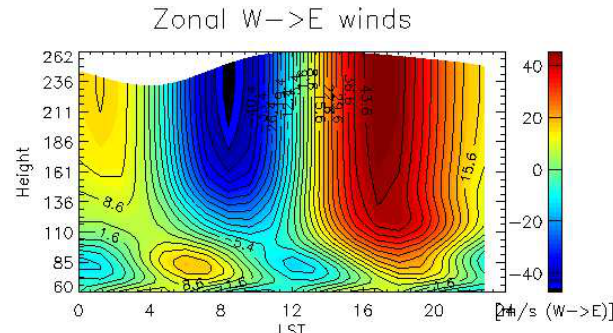
Fig. 7. The zonal wind speeds(positive eastward), local solar time (LST) vs height, from MarTIM with the (2,2) tide, for solar mini- mum conditions, L s =0 ◦ .